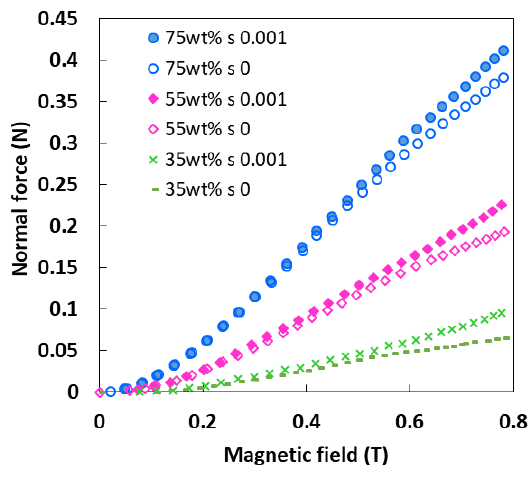
Figure 1. Comparison of normal forces versus the magnetic field at different strain conditions with various concentration of carbonyl iron particles (CIPs).